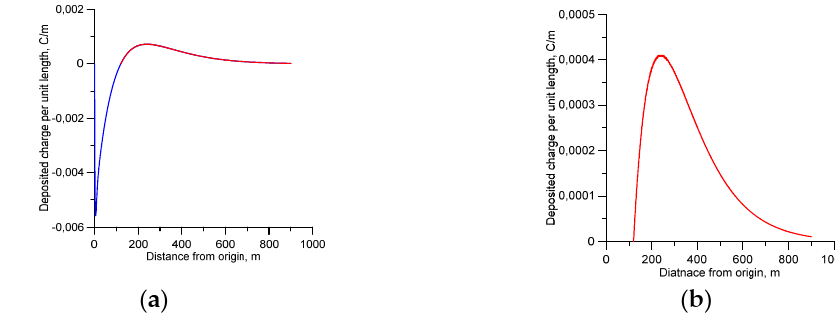
Figure 11 . The charge deposited in space ahead of the origin of the streamer burst. ( a ) non conducting streamer channel where the negative charge remains where it is created; ( b ) partially conducting streamer channel where the negative charge is transported back to the streamer origin. The parameters used in the calculation are identical to those used to obtain figures 8a and 8b.